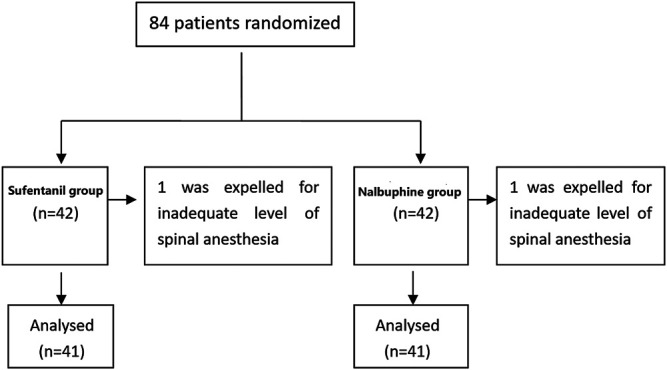
Study flow chart.